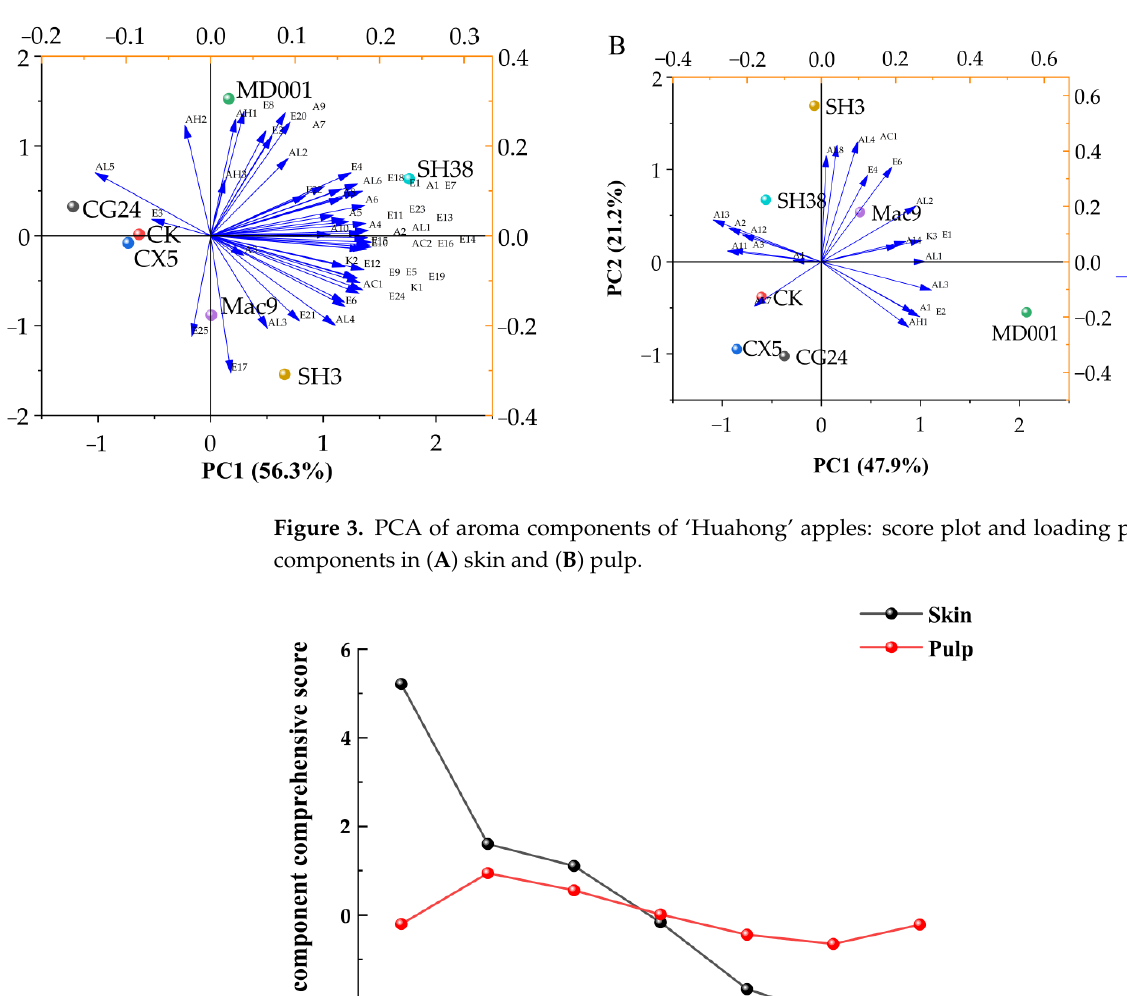
Figure 3. PCA of aroma components of ‘Huahong’ apples: score plot and loading plot of aroma components in ( A ) skin and ( B ) pulp.